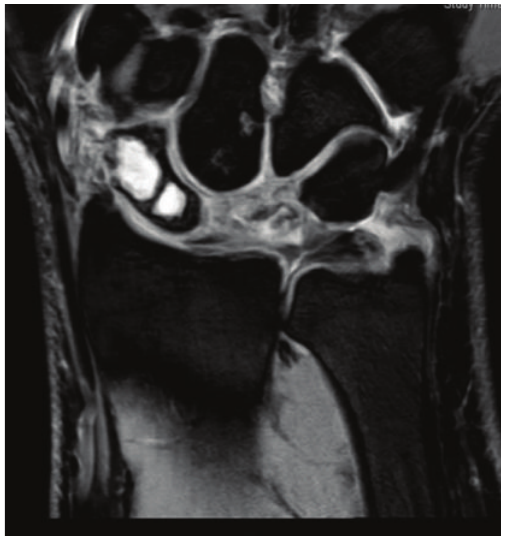
Figure 3: MRI: Giant interosseous ganglion of the scaphoid with cortical bone disrupture, lunate collapse, no severe chondropathy fossa lunata, and capitate.